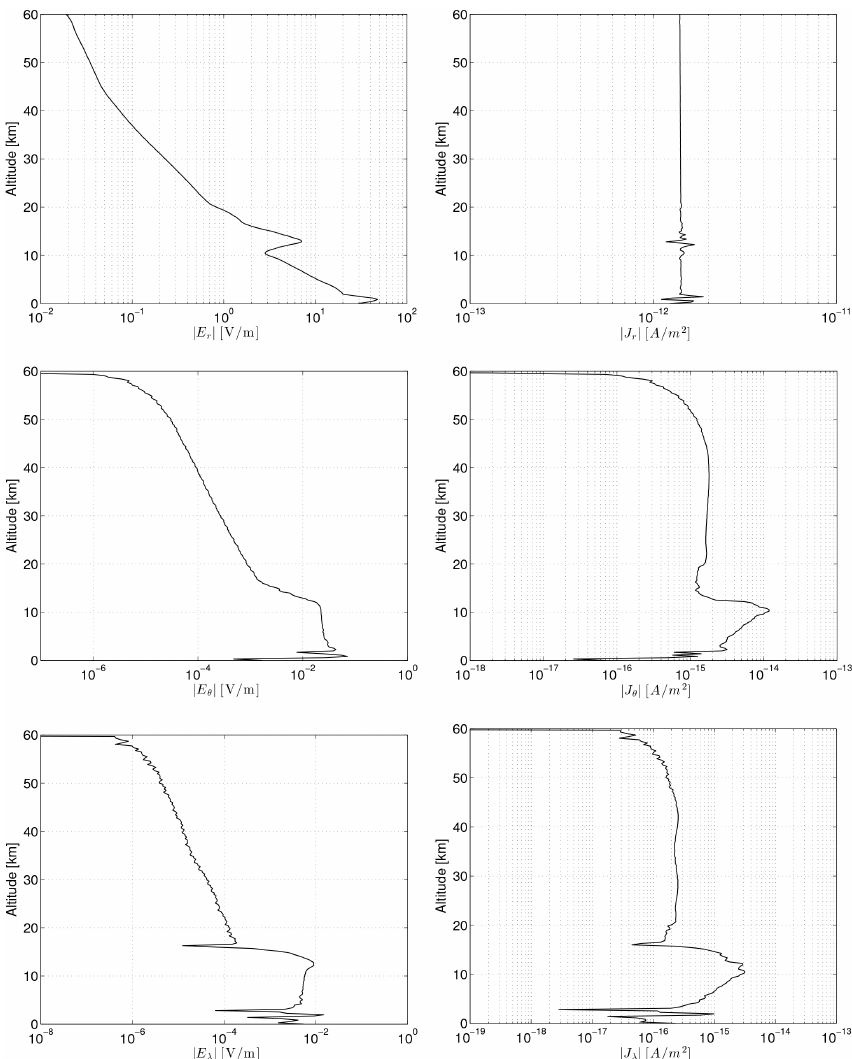
Figure 11. From top to bottom, fair weather plots of | E r | (left) and | J r | (right), | E θ | (left) and | J θ | (right), and | E λ | (left) and | J λ | (right) vs. altitude, without (dashed) and with (solid) clouds, at 180 ◦ longitude and 0 ◦ latitude.